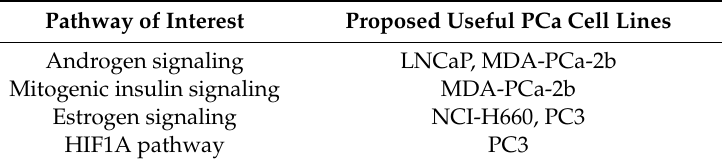
Table 4. Summary